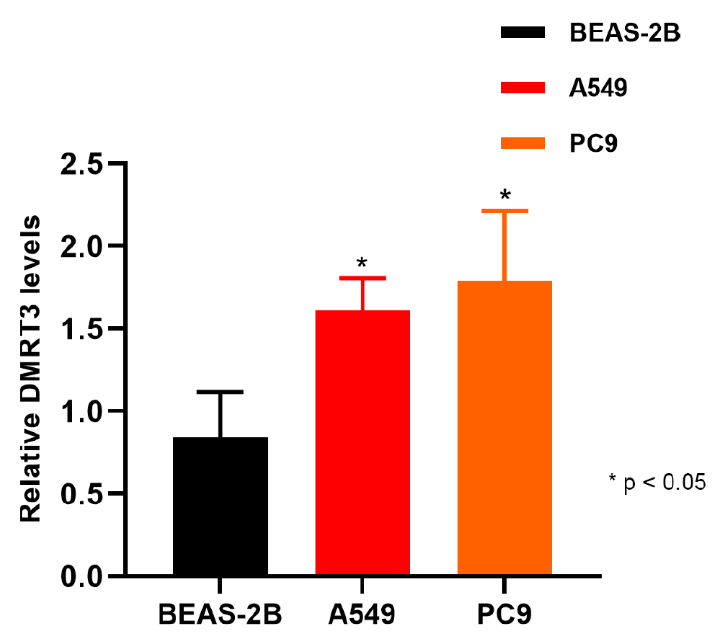
Figure 13. Expression of DMRT3 in A549, PC9, and Beas-2B.